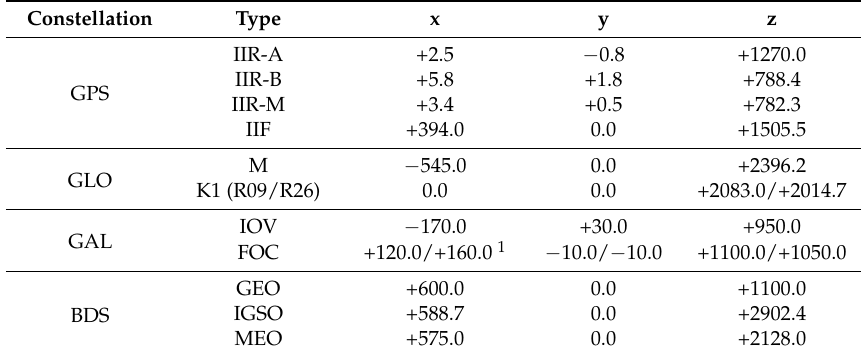
Table 4. The average antenna phase offset for GNSS satellites (unit: